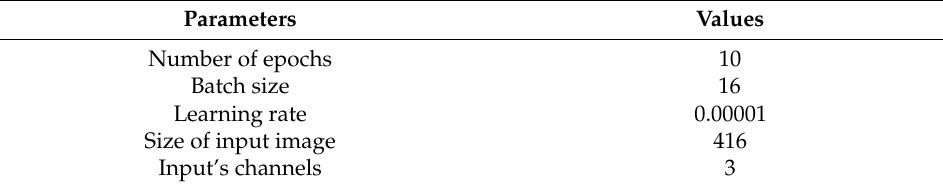
Table 3. Second training parameters of the car object detection model.